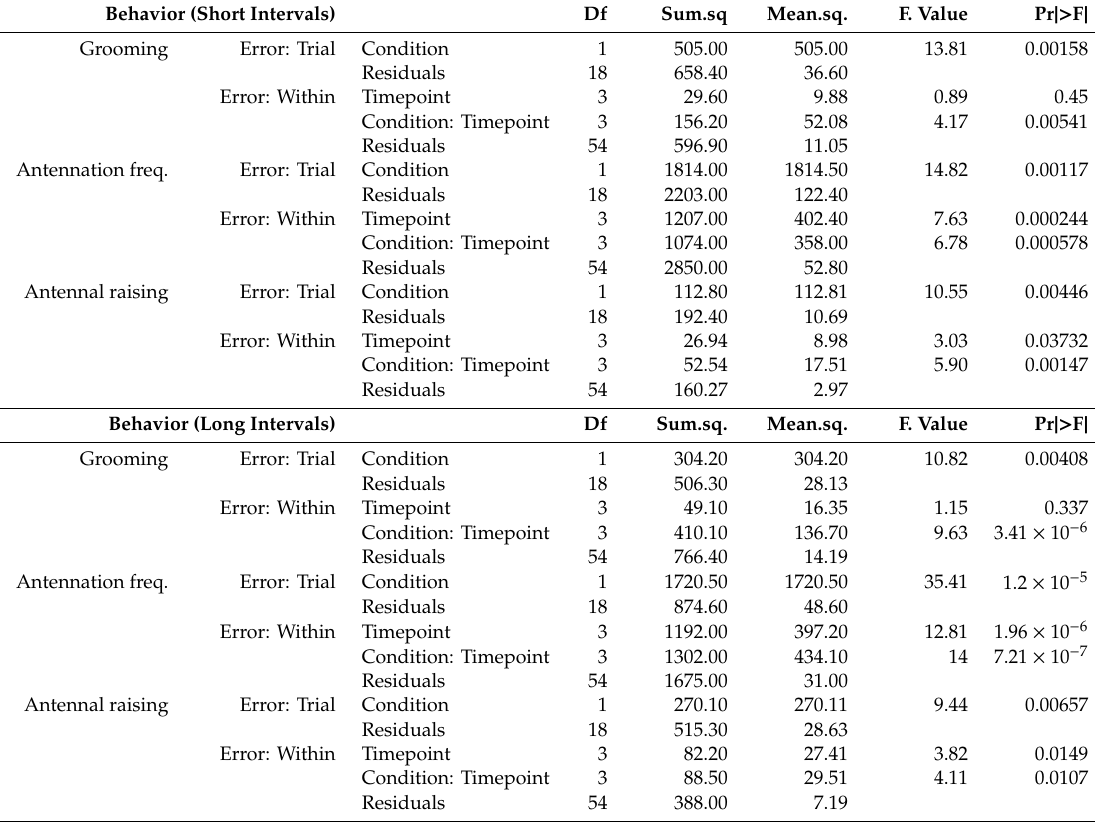
Table 1. Repeated Measures ANOVA on repeated exposure data. Condition refers to the treatment group (experiment versus control), while timepoint refers to the timepoints shown in Figure 4. Df = degrees of freedom, Sum.sq. = sum of squares, Mean.sq. = mean of squares, Pr |> F | = p -value. ANOVA Formula = (Behavior ~ Condition ×